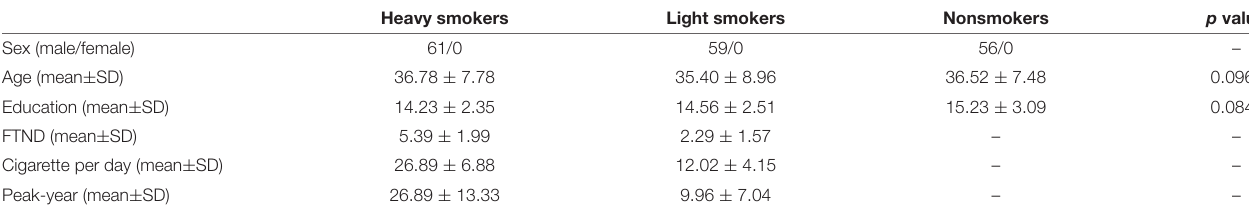
TABLE 1 | Demographic and smoking behaviors.